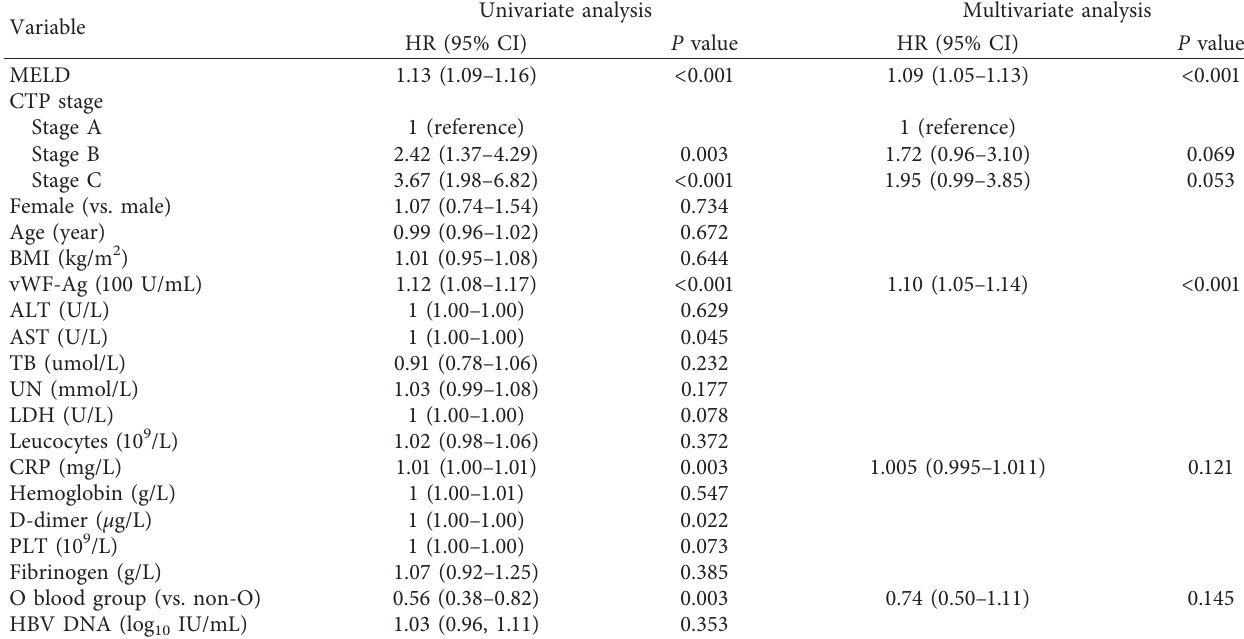
Table 2: Univariate and multivariate analyses for transplant-free mortality in patients with liver cirrhosis.